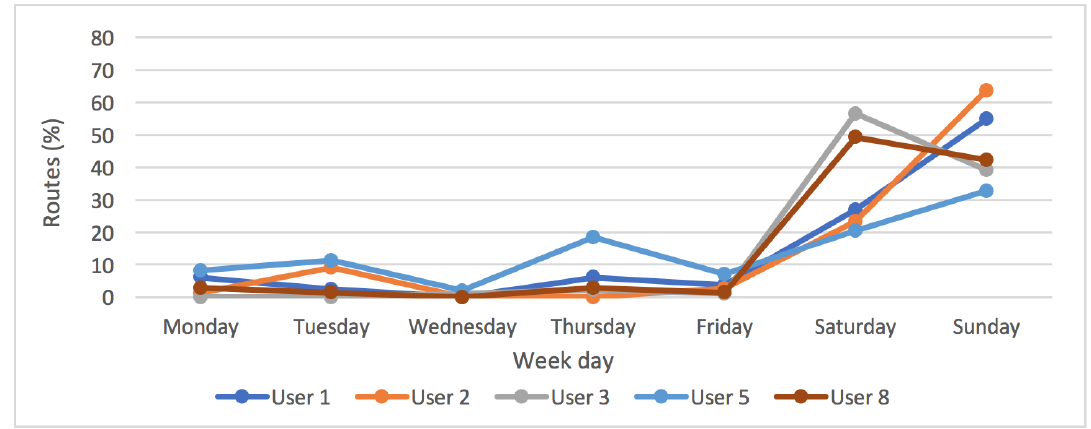
Figure 12. Distribution of the routes cycled by users from the first group over the week.